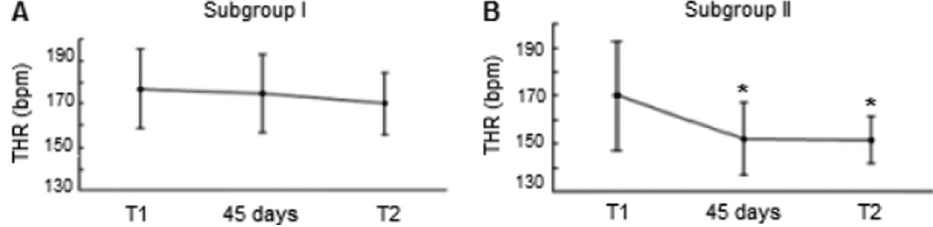
Figure 2. Training heart rate (THR; bpm) calculated at the three evaluated time points of the supervised physical exercise regimen. Subgroup I ( A ) showed no difference between the evaluation periods. Subgroup II ( B ) showed different progressions during the training period according to ANOVA. T1: 3 months after study initiation, T2: 6 months after study initiation. *P=0.009, THR at T1 compared with THR at 45-days for subgroup II (ANOVA); *P=0.025, THR at T1 compared with THR at T2 for subgroup II (ANOVA).